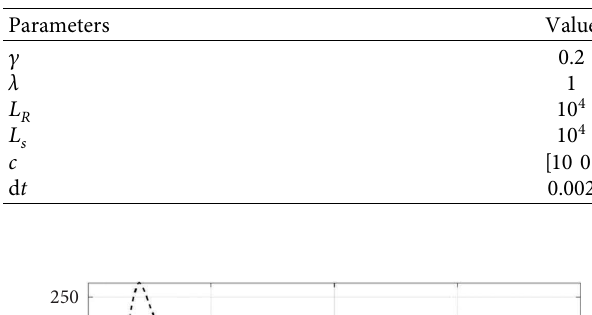
Table 8: Parameters for obtaining K and simulation for τ � 1 s , 5s and sinusoidal disturbance.